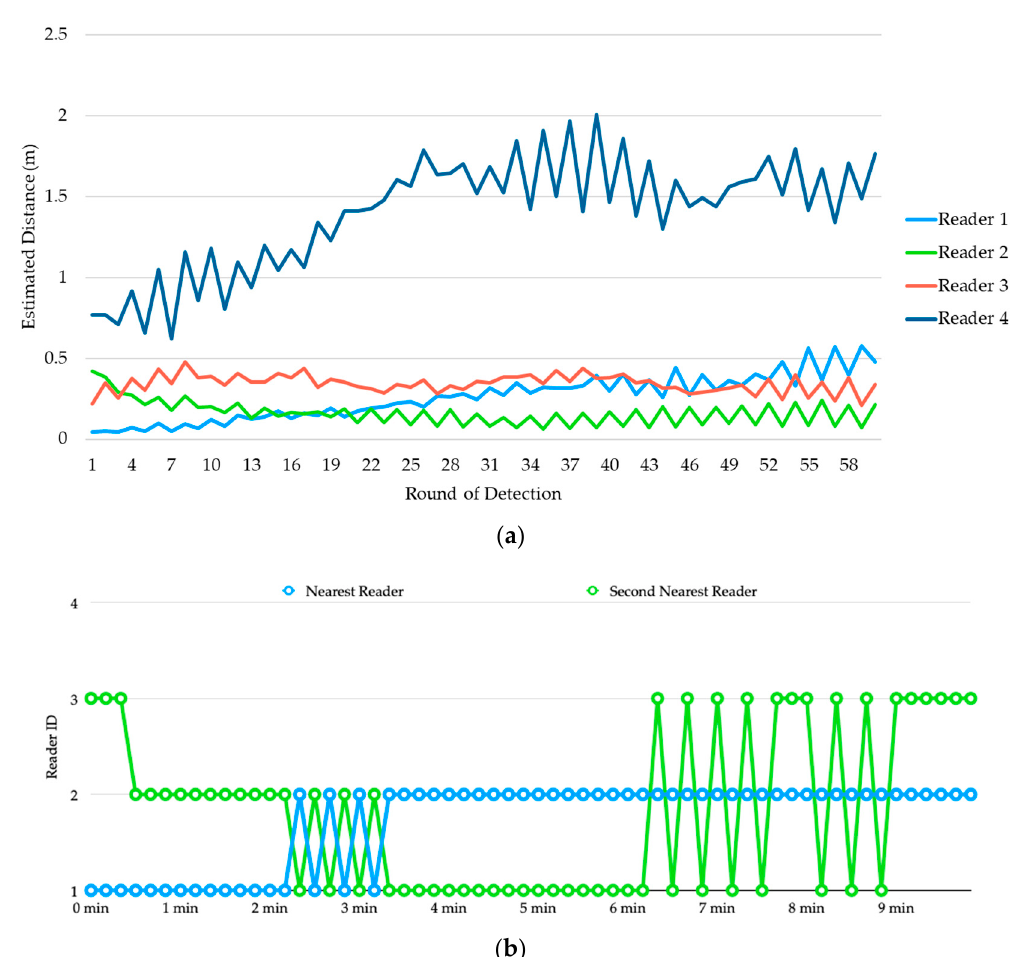
Figure 10. Experiment 1: ( a ) estimated distances of transmitter 2 from the four readers, ( b ) determination of occupancy for vehicle 2.